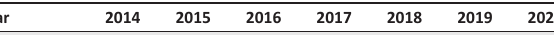
TABLE 4: Grade 12 learners’ mean pass rate in probability